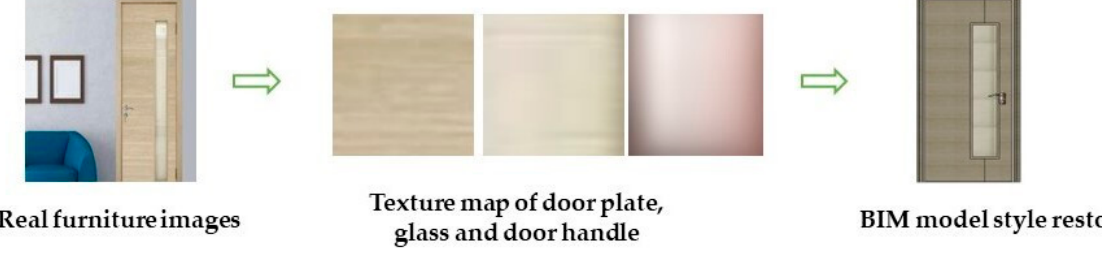
Figure 8. The BIM style restoration example.